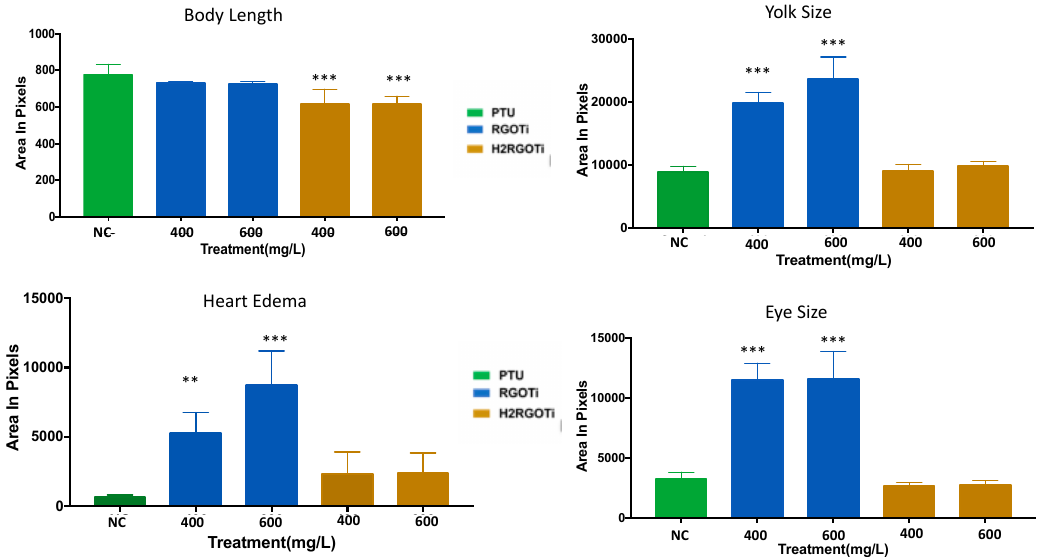
Figure 2. Specific teratogenic changes induced by RGOTi and H 2 RGOTi. Average body length, yolk, heart, and eye size were measured using ImageJ software version 1.52a. Twenty-five embryos were used per concentration. One-way analysis of variance (ANOVA) was used to compare the di ff erences between the average of the imaged areas between groups. ** p < 0.01 and *** p < 0.001, n = 10.